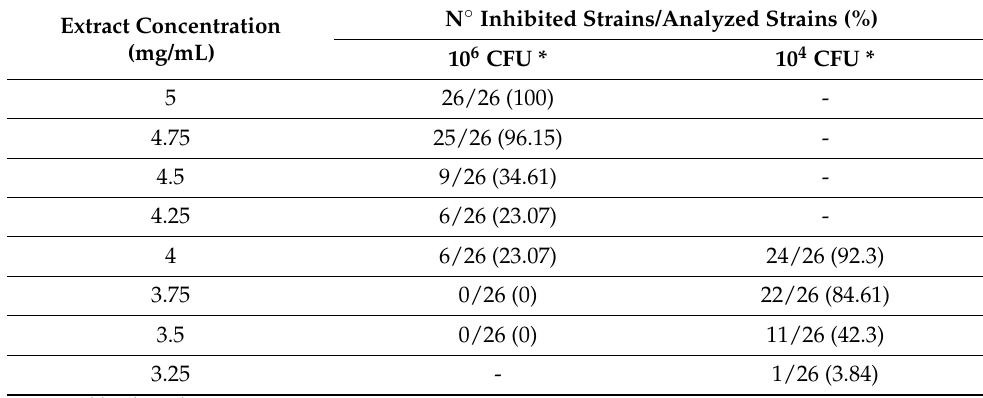
Table 2. In vitro efficacy of AGE with concentrations ranging from 5 mg/mL to 3.5 mg/mL and from 4 mg/mL and 3.25